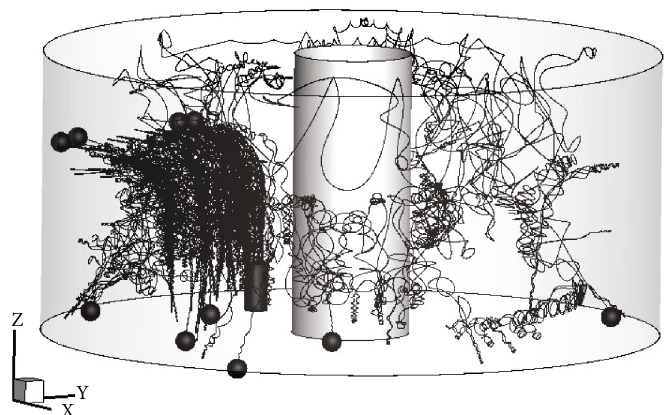
Figure 23: Primary electron trajectories under 10 times the initial magnetic fi eld